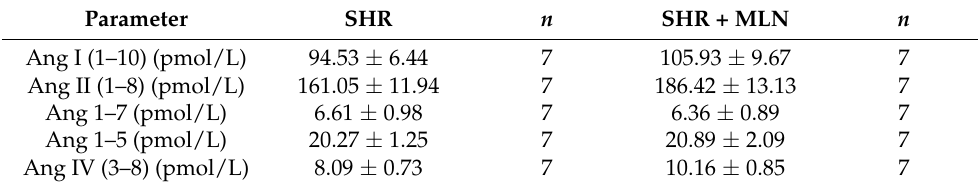
Table 2. The equilibrium angiotensin peptides levels in